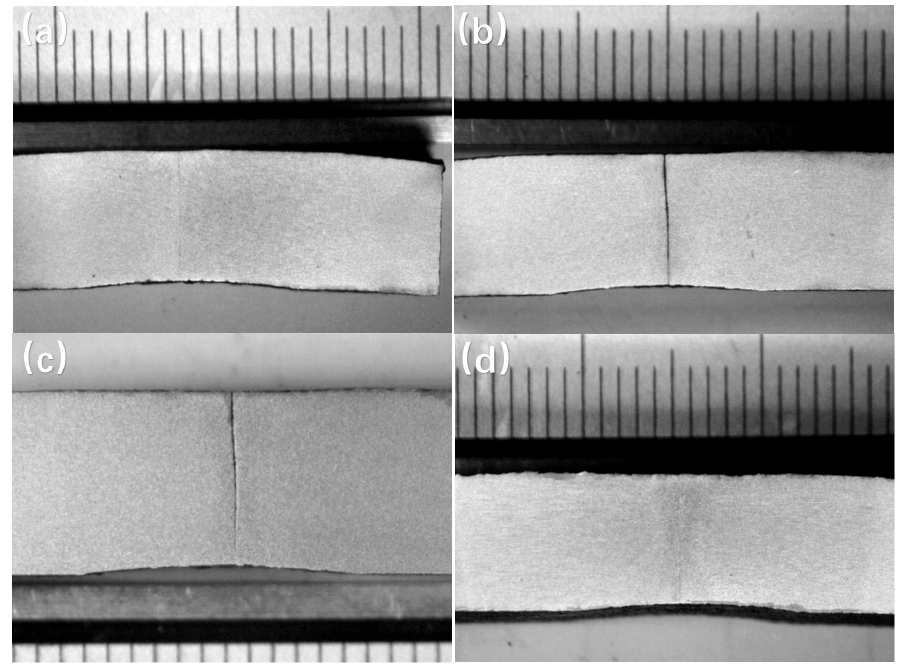
Figure 3. Macromorphology of weld seam of 1# cracking pipe ( a ) C1; ( b ) C2; ( c ) C3; ( d ) C4.